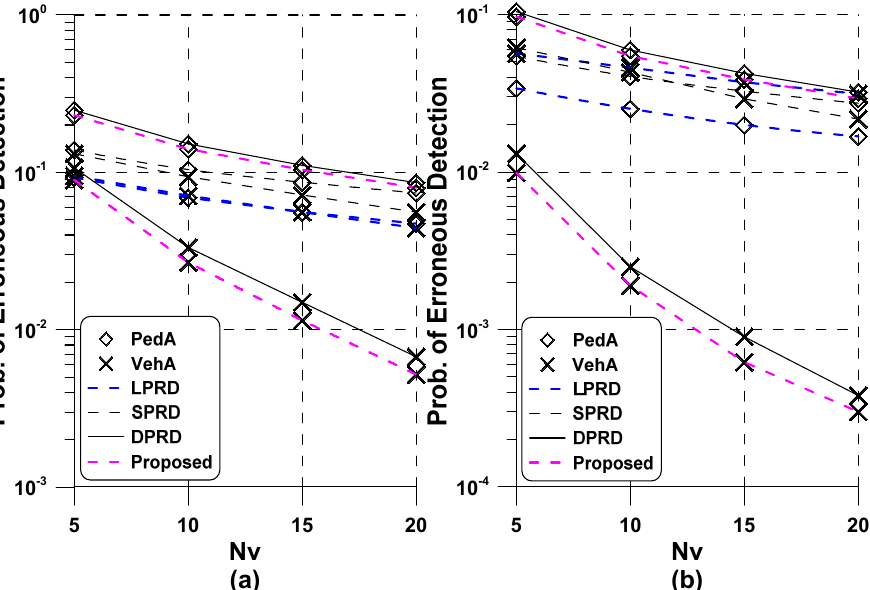
Figure 4. Performance comparison of the benchmark and proposed methods versus N v : ( a ) SNR = − 5 dB ( b ) SNR = 0